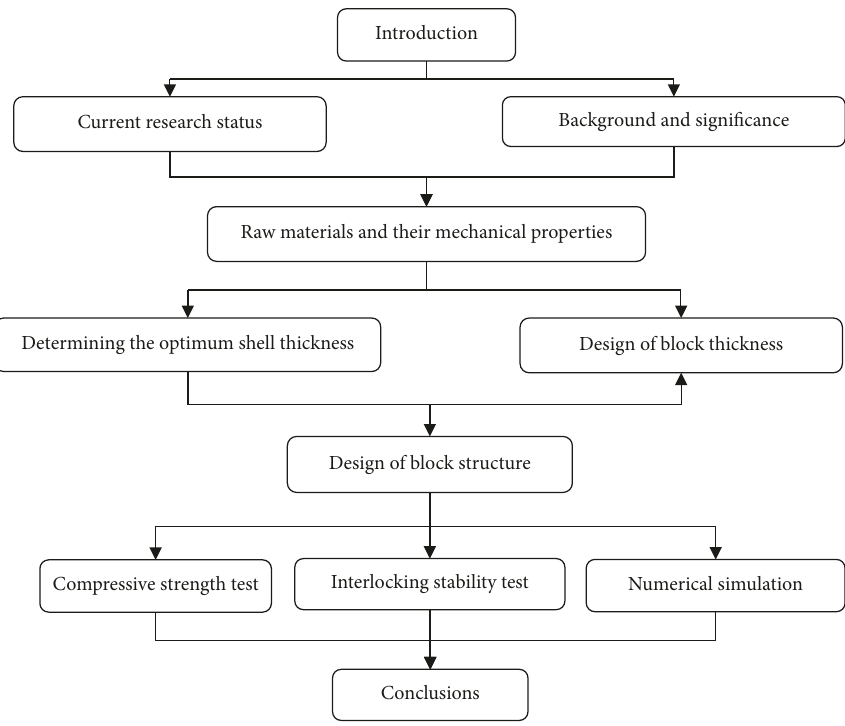
Figure 1: The flow chart of the research methodology of this study. Table 1: Chemical composition of P.O 42.5 Cement (%wt).